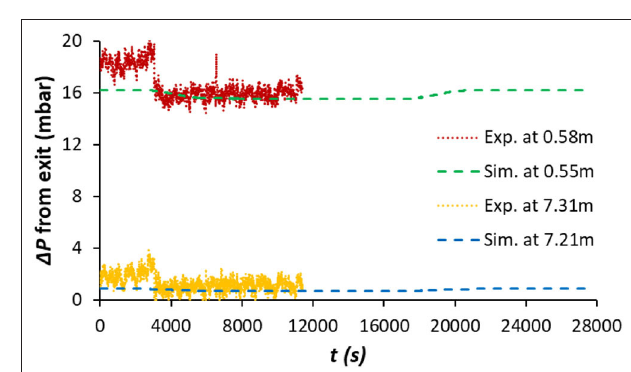
FIGURE 6 | Temporal evolution of the temperature at three different heights in the bed as predicted by the transient simulation and the experiment. FIGURE 7 | Temporal evolution of pressure drop at two different heights in the bed as predicted by the transient simulation and the